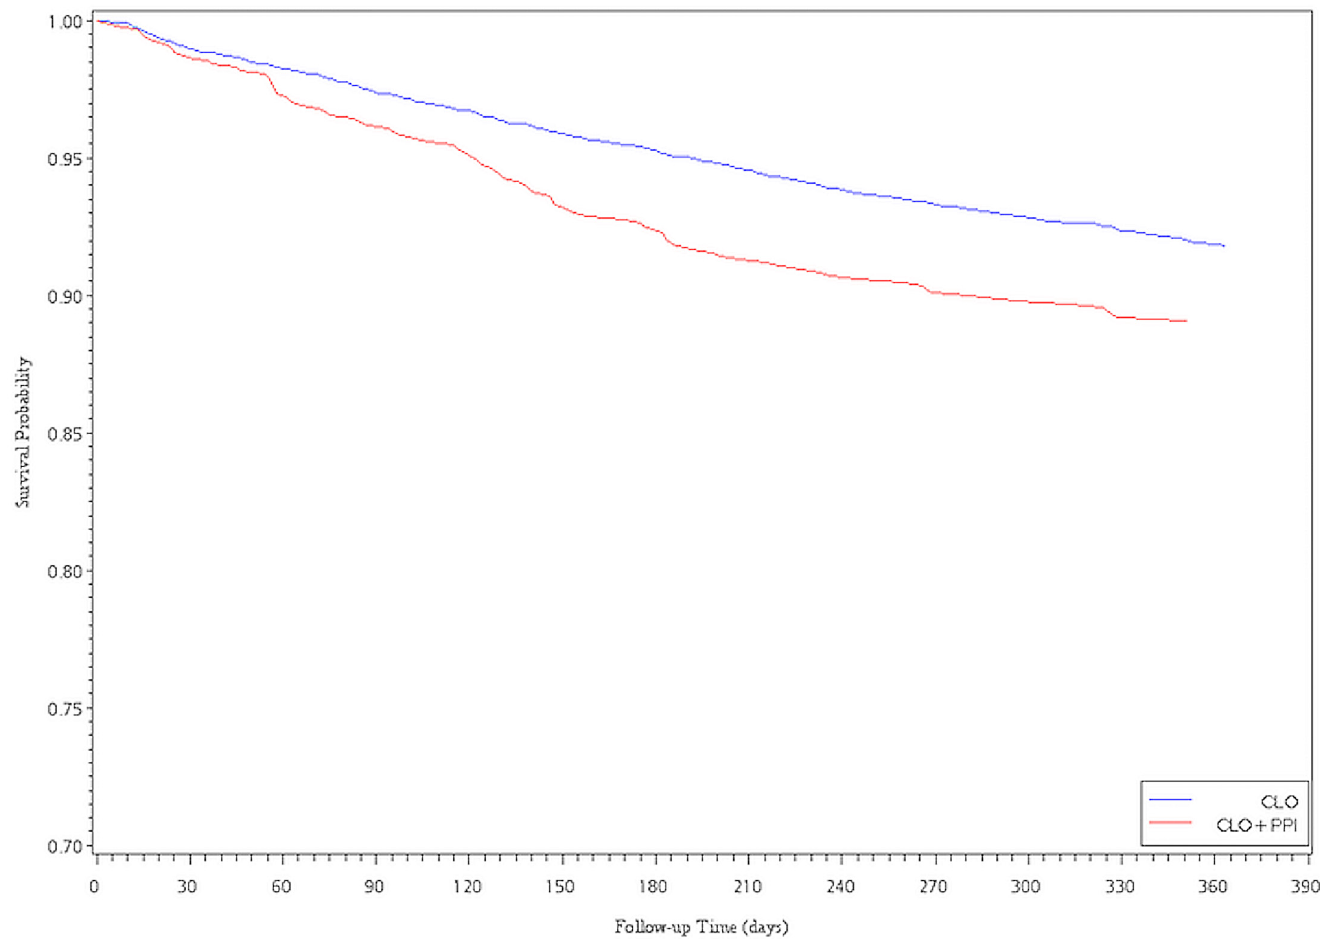
Fig 2. Survival analysis of ACS versus exposure to ClO plus PPI and ClO after LES implantation.